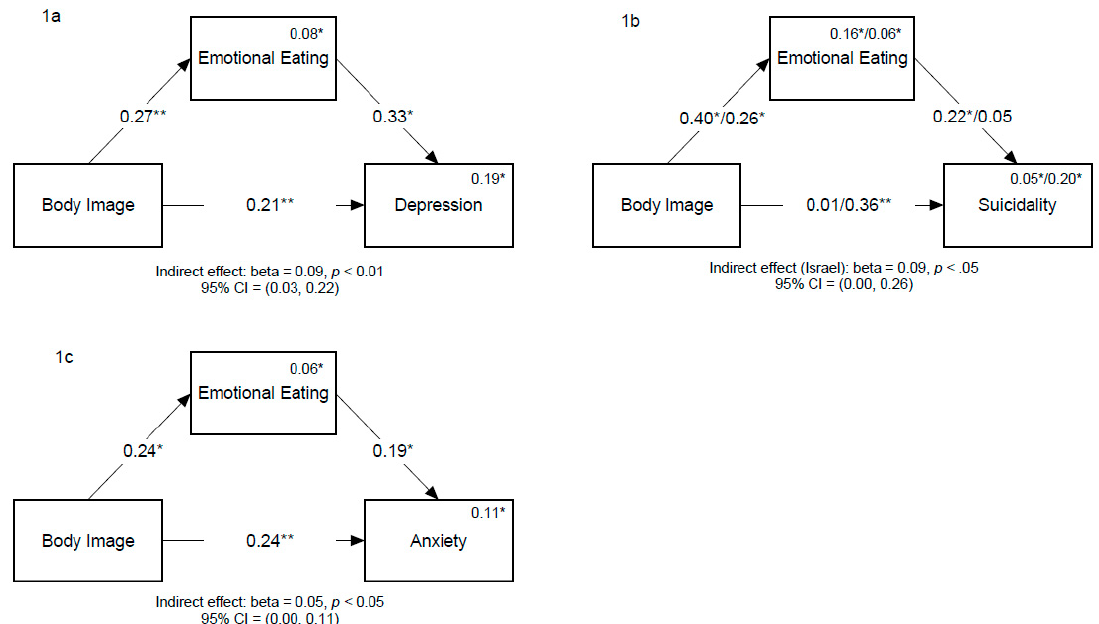
Figure 1. Moderated-Mediation models for depression ( 1a ), suicidality ( 1b ), and anxiety ( 1c ) outcomes. Numbers on solid lines are standardized path coefficients for the combined Israel/US samples. Note: Numbers above endogenous variables names are multiple squared correlations. The analysis shown in (1b) was performed controlling for gender (not presented in the figure). * p < 0.05; ** p < 0.01.